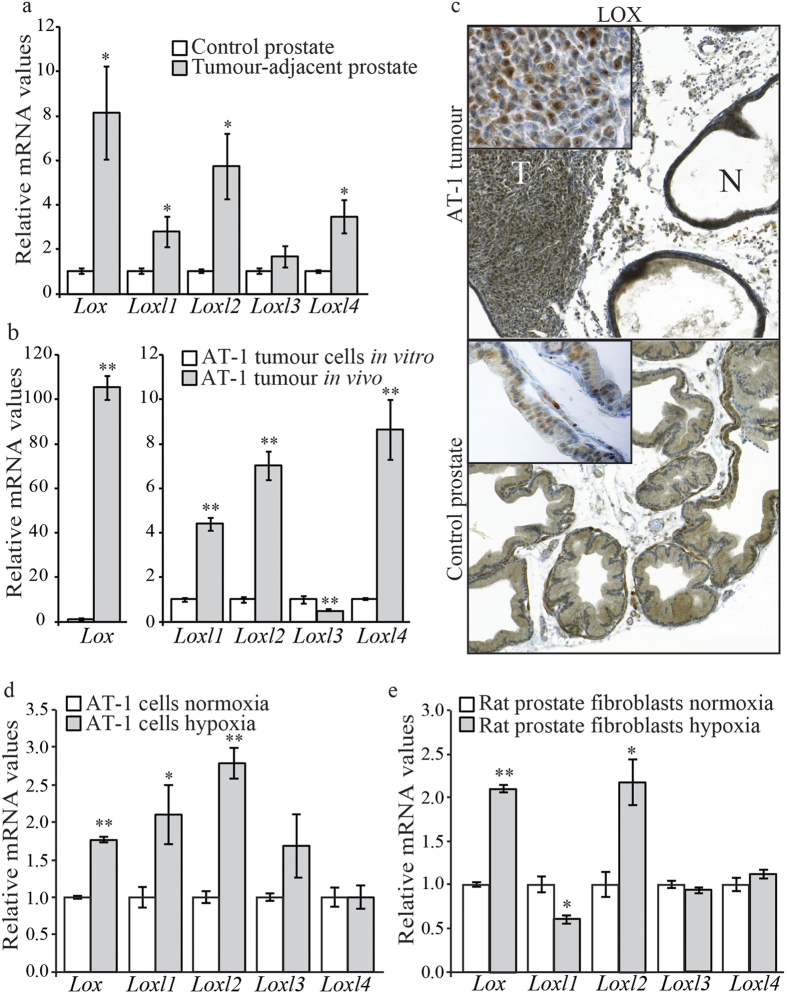
Expression of Lox and Loxl1—Loxl4 mRNAs in orthotopic rat prostate tumours and in the surrounding normal rat prostate tissue.(a) Relative mRNA expression of Lox and Loxl1—Loxl4 in non-malignant tumour-adjacent rat prostate tissue (n = 8) expressed in relation to the levels of each factor in tumour-free control rat prostate tissue (n = 7) (b) Relative mRNA expression of Lox and Loxl1-Loxl4 in orthotopic AT-1 tumours (n = 8) on day 10 after tumour implantation, expressed in relation to the levels of each factor in the AT-1 tumour cells in vitro. (c) Representative sections from a 10-day orthotopic AT-1 rat prostate tumour (T), tumour-adjacent normal rat prostate tissue (N), and tumour-free control rat prostate tissue stained for LOX (inserts show LOX staining in higher magnifications). (d,e) Relative mRNA expression of Lox and Loxl1-Loxl4 in rat prostate AT-1 tumour cells (d) and in primary rat prostate fibroblasts grown in vitro (e) under normoxic or hypoxic conditions for 24 h. Values are mean ± SEM; *p < 0.05, **p < 0.01.